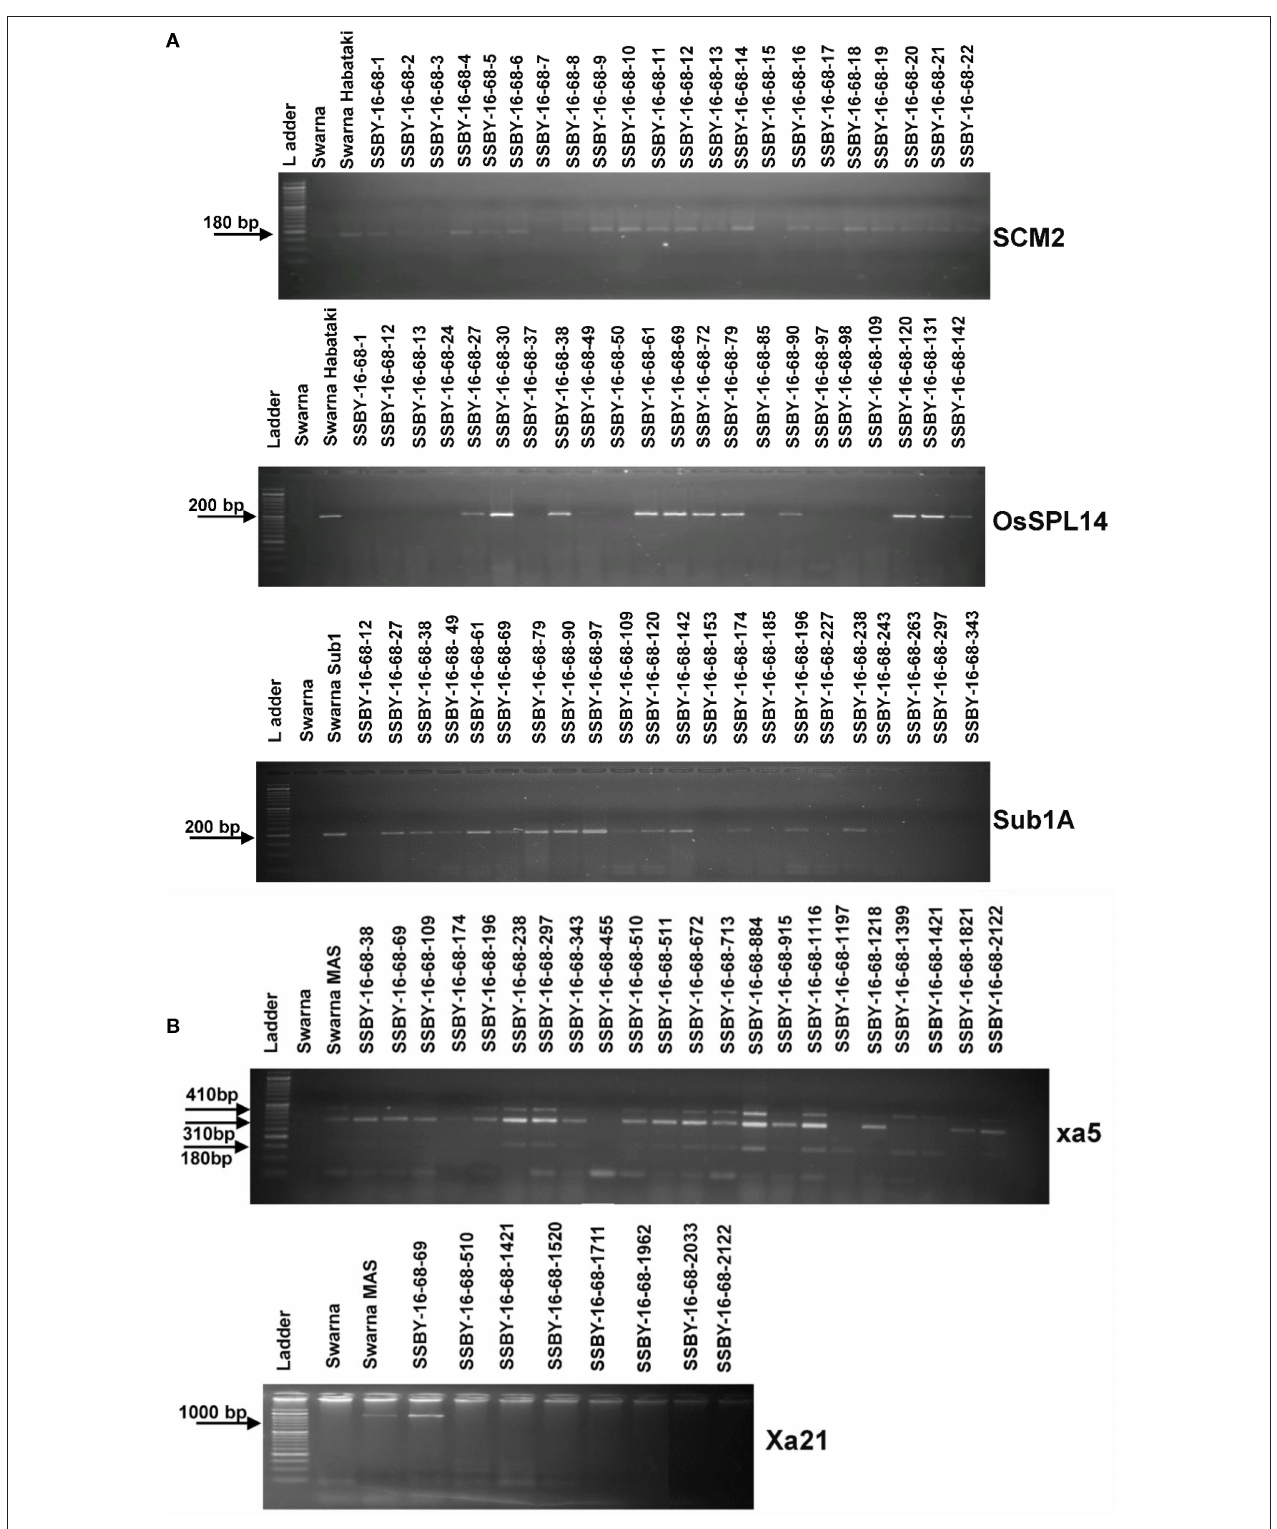
FIGURE 4 | Representative electropherogram of BC 2 F 2 progenies in the background of Swarna variety for (A) yield component QTLs, OsSPL14 , and SCM2 , and submergence tolerance (B) bacterial blight resistance genes, xa5 and Xa21 . The designations on the top of the lane indicate the genotypes used, and the L is 100 bp DNA ladder. The desired base pair of the markers are written on the left.